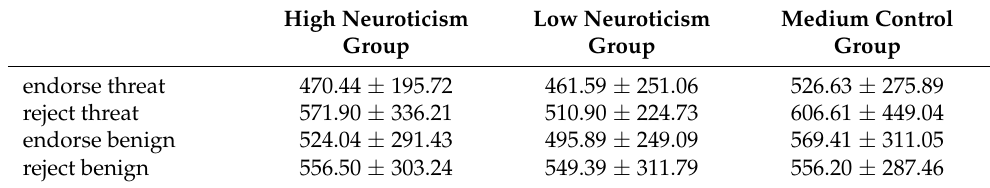
Table 7. Descriptive statistics of the four reaction time variables. ( M ± SD ; Unit: ms).